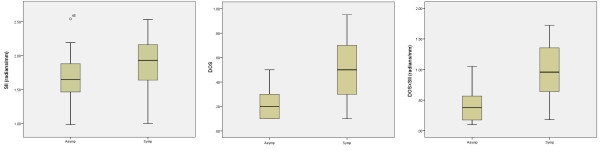
Distribution of plaque SII (left), degrees of stenosis (DOS, middle) and the product of the two (right) in the symptomatic and asymptomatic plaque groups. Degrees of stenosis are given as degree of stenosis (%)/100% (i.e. 0.5 corresponds to 50%, etc.).